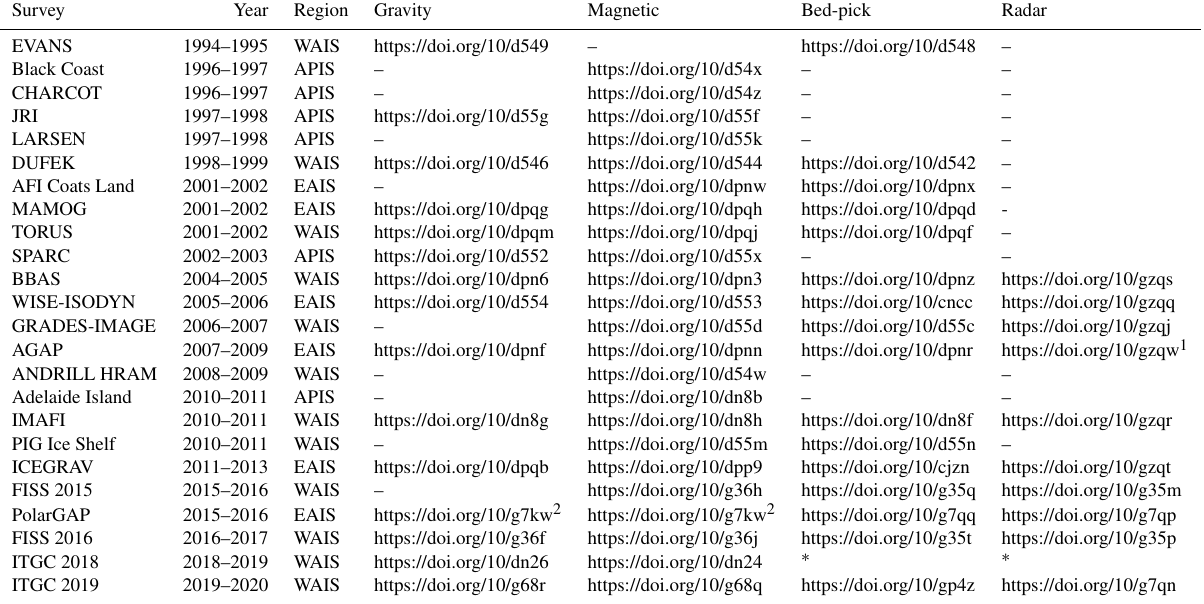
Table 3. Short digital object identifiers (DOIs) for the gravity, magnetic, bed-pick, and 2-D radar datasets of each survey flown by BAS and included in this data release. Abbreviations used are the same as in Table 1. 1 For the AGAP radar data, the US-led survey lines can be found at https://doi.org/10.1594/IEDA/313685 (Bell, 2011). 2 For the PolarGAP survey, data can be downloaded from both the ESA and BAS data catalogues, but the DOI for the gravity and magnetic data (https://doi.org/10.5270/esa-8ffoo3e, Forsberg et al., 2017) belongs to ESA. If using the PDC data catalogue, the PolarGAP gravity and magnetic data can be downloaded from https://data.bas.ac.uk/full-record. php?id=GB/NERC/BAS/PDC/01583 (last access: 18 July 2022) and https://data.bas.ac.uk/full-record.php?id=GB/NERC/BAS/PDC/01584 (last access: 18 July 2022), respectively. “*” indicates that the data are not held at BAS, but instead are available on the CReSIS data portal (https://data.cresis.ku.edu/, last access: 18 July